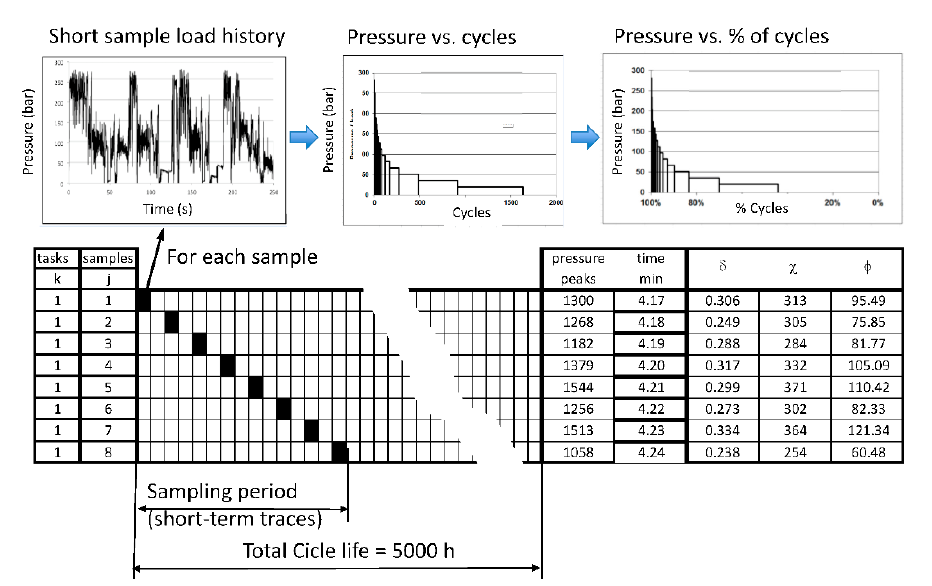
Figure 1. Scheme of load histories sampling and treatment.